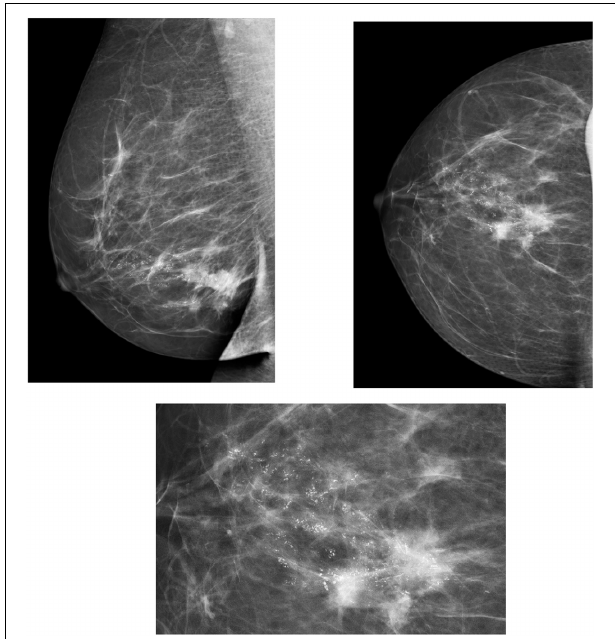
FIGURE 1 | Microcalcifications in breast mammography. Highly suggestive of malignancy BIRADS 5.